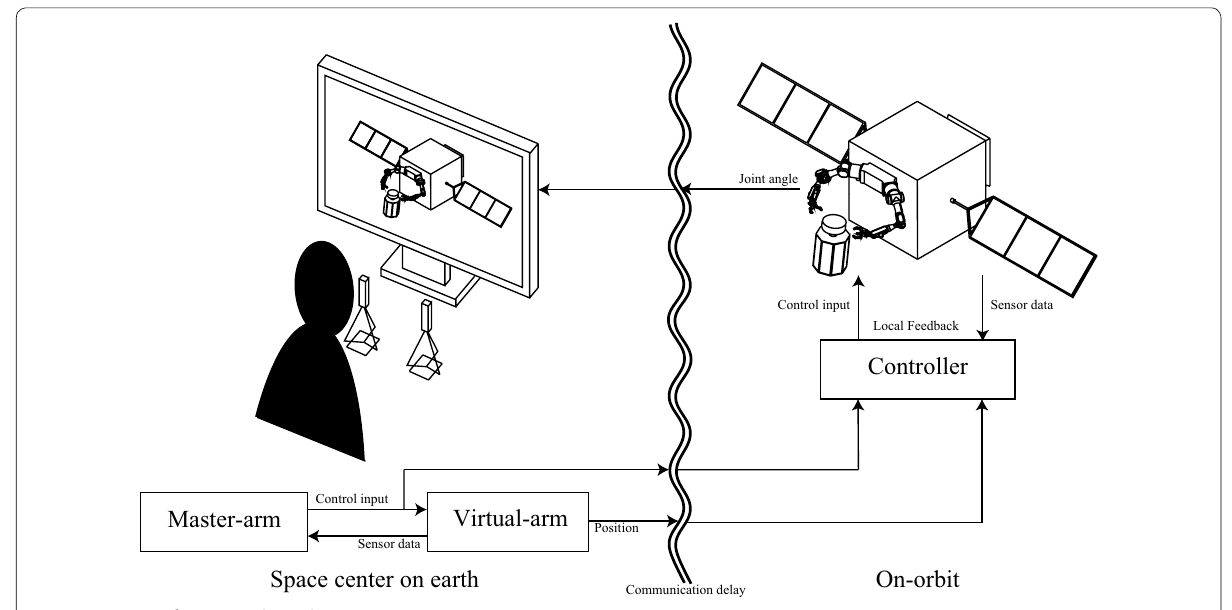
Fig. 1 Concept of a space robot teleoperation